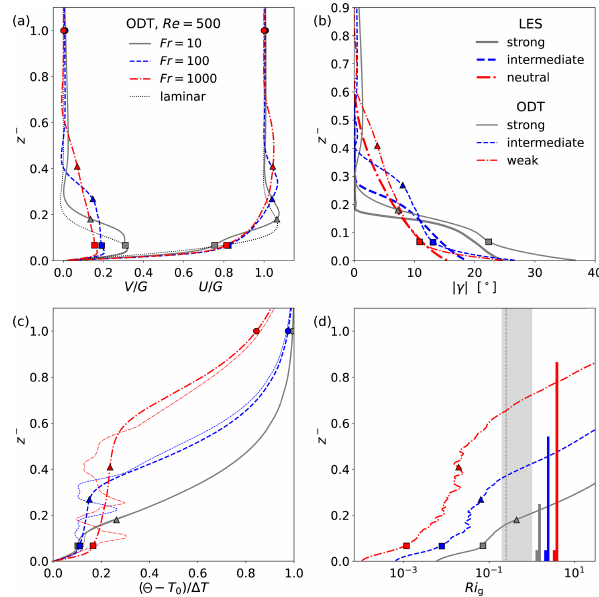
Figure 8. Synopsis of various simulated vertical property pro- files. ODT results (solid and broken lines) at t − = 4 have been ob- tained for W001 (N500 in panel b ), I015, and S158 varying Fr for fixed Re = 500. (a) Ensemble-averaged geostrophic U (right) and ageostophic V (left) velocity components together with the steady laminar Ekman flow solution (dotted) according to Eqs. (2) and (3). (b) Wind-turning angle of the ensemble-averaged velocity vector together with reference LES (thick lines) from Taylor and Sarkar (2008) for a slightly different case set-up and only approximately matching stratification regimes. (c) Ensemble-averaged (thick lines) and instantaneous (thin lines) temperature profiles. (d) Gradient Richardson number Ri g of the ensemble-averaged state. The Ri g = 0 . 25 criterion (thin vertical line) and the widely accepted transi- tional margin 0 . 2 (cid:54) Ri g (cid:54) 1 (shaded region) are given for orienta- tion. Vertical bars (same color and order as profiles) mark the turbu- lence range of scales by the smallest and largest near-surface ODT eddy events that reach down into the viscous sublayer but do not touch the surface. Symbols mark the vertical locations z = D ( (cid:3) ), δ ∗ ( ◦ ), and δ 1 / 2 ( (cid:52) ),